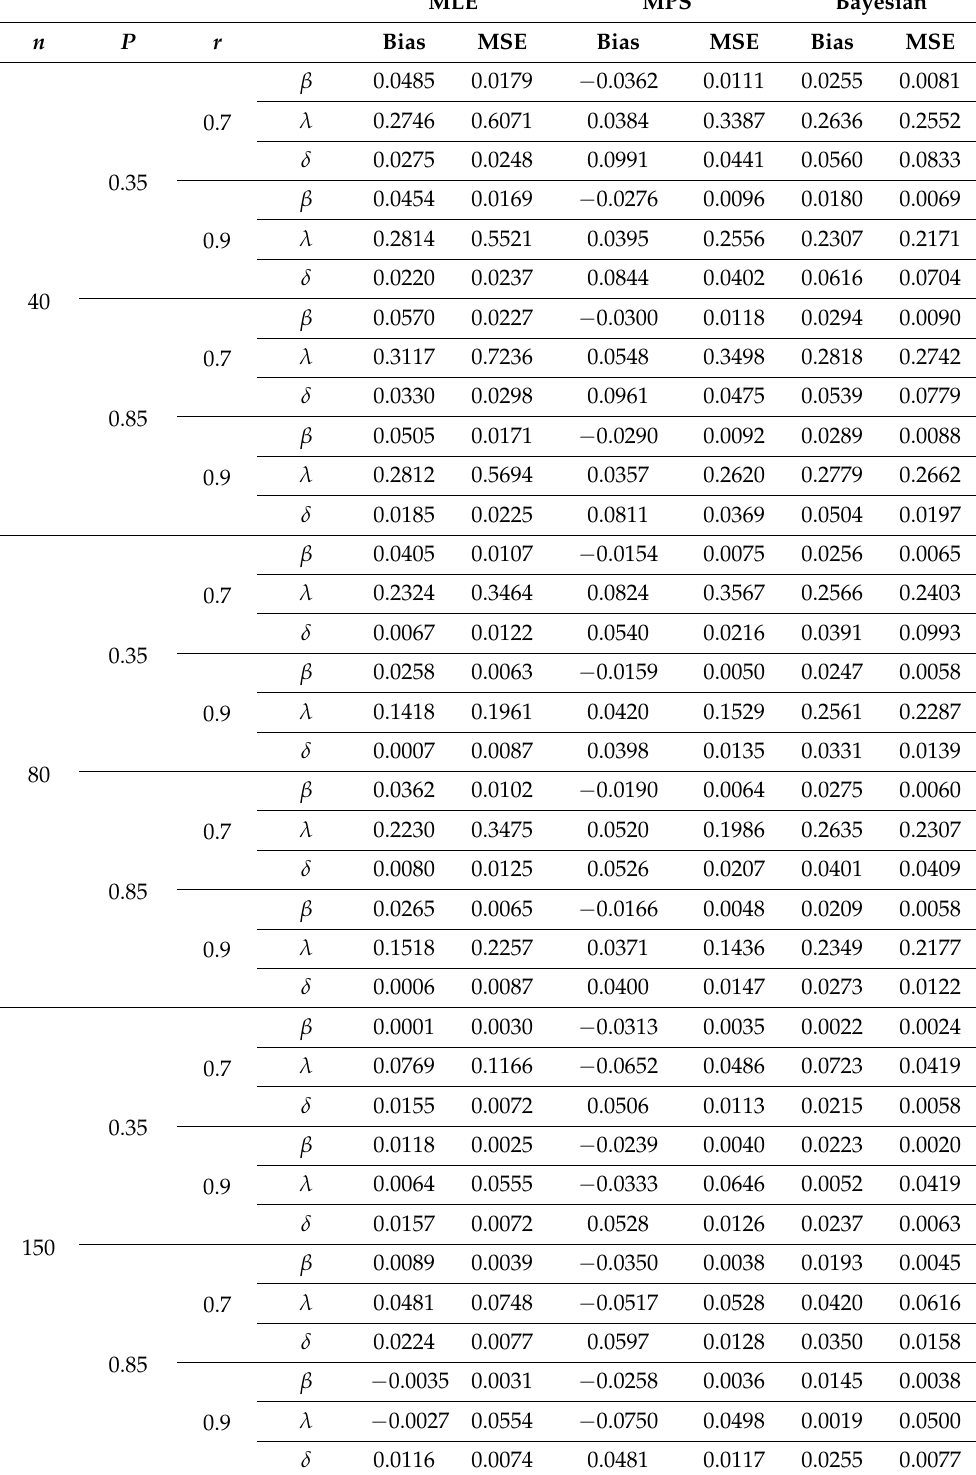
Table 1. The MLE, MPS, and Bayesian of the WE parameters under the PTIICS with random removal for Case